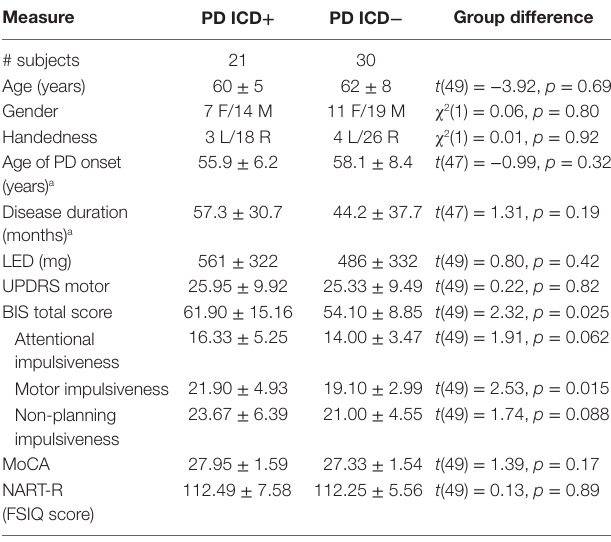
Table 1 | Overview of the demographic and clinical characteristics of the impulse control disorder (ICD) + and ICD − groups (mean ±